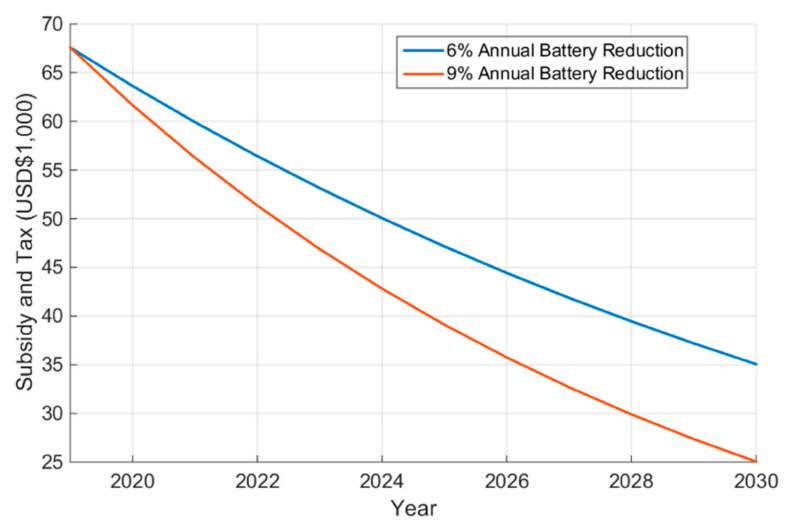
Figure 12. The amount of tax and subsidy required for electric buses to be at least on a par or cheaper than diesel buses between 2019 and 2030, with diesel costs of USD$3.101/L, for buses on the minimum distance